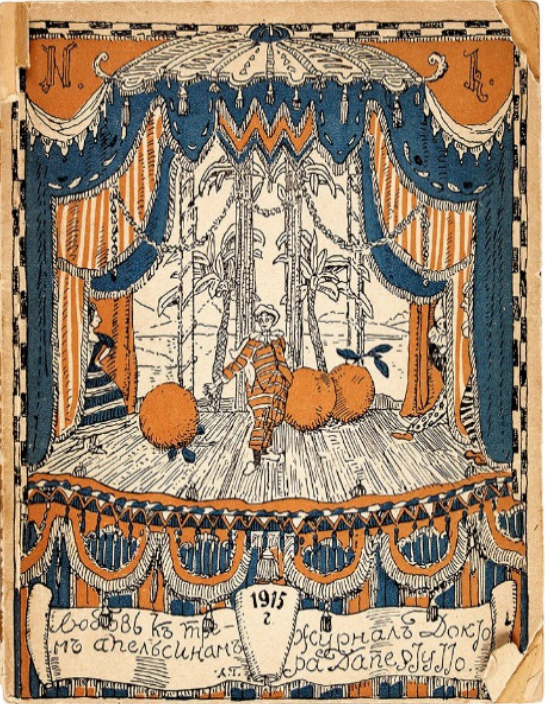
Figure 5. The Love for Three Oranges, Journal of Doctor Dapertutto. 1915. Cover by A.Y. Golovin.